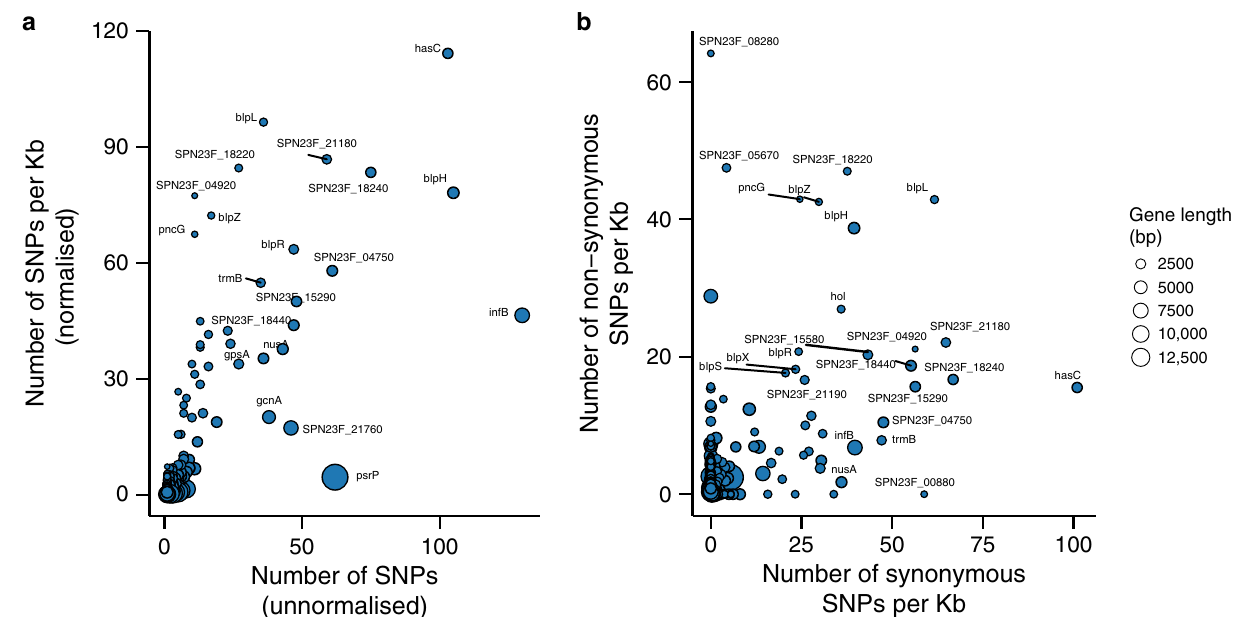
Fig. 8 Highly mutated genes during natural colonisation. a Normalised and unnormalized number of SNPs detected in each gene during colonisation episodes. Normalisation was done by estimating the number of SNPs per kilobase pair (Kb). b Normalised number of synonymous and non-synonymous SNPs per Kb in each